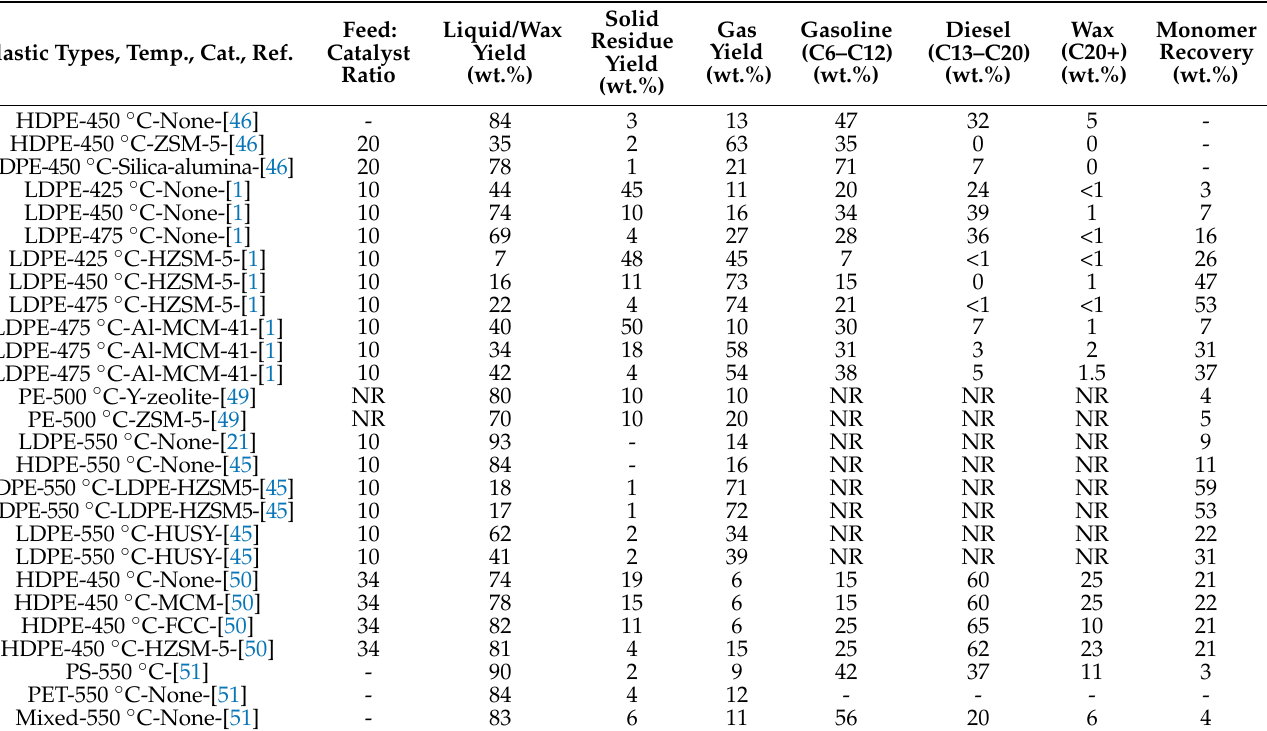
Table 3. Slow pyrolysis of different plastic